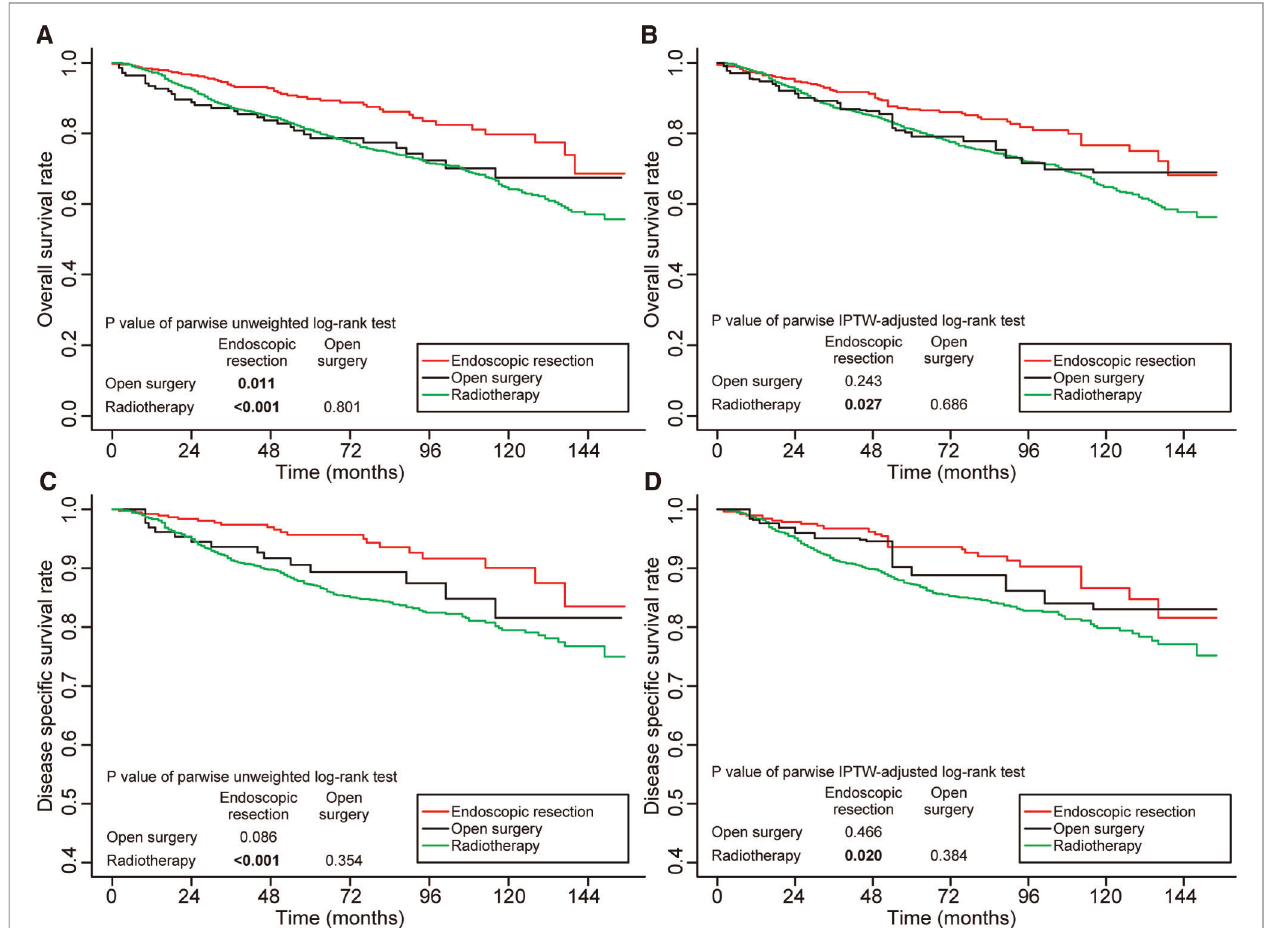
FIGURE 4 | Kaplan – Meier curves for overall survival ( A,B ) and disease-speci fi c survival ( C,D ) before and after weighting in patients aged <65 years. Signi fi cant p values are in bold font. IPTW, inverse probability of treatment